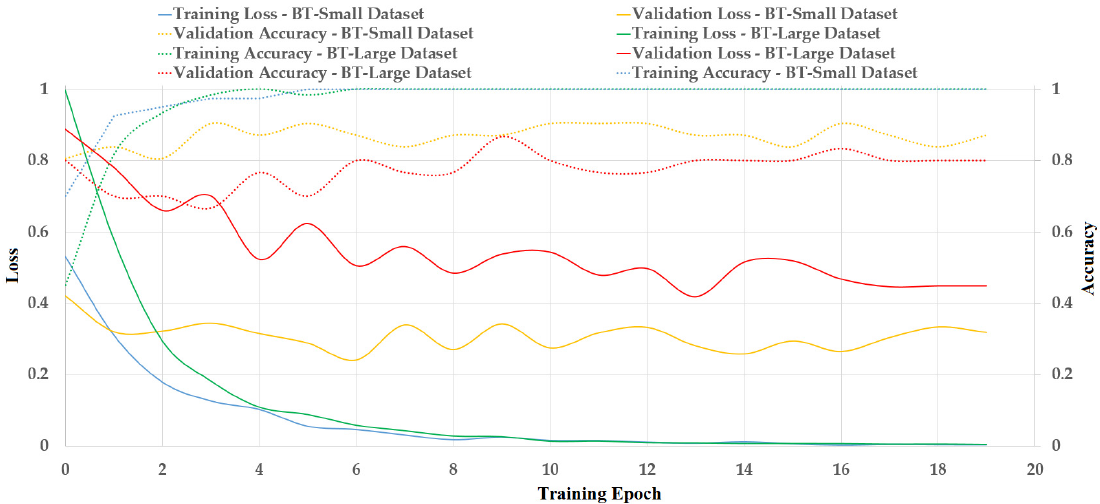
Table 6. Parameters for the training procedure of the MLP and FS networks in our study.